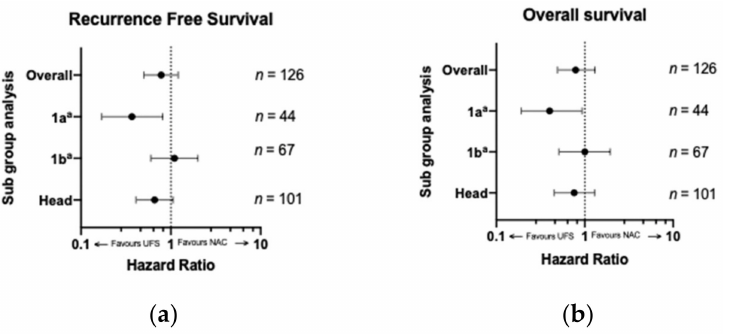
Figure 3. ( a ) Recurrence-free and ( b ) overall survival comparing UFS to NAC by subgroup analysis. Radiological stage 2a and tail were not included due to inadequate sample size. Legend: UFS—upfront surgery; NAC—neoadjuvant chemotherapy; a —8th addition TNM staging system